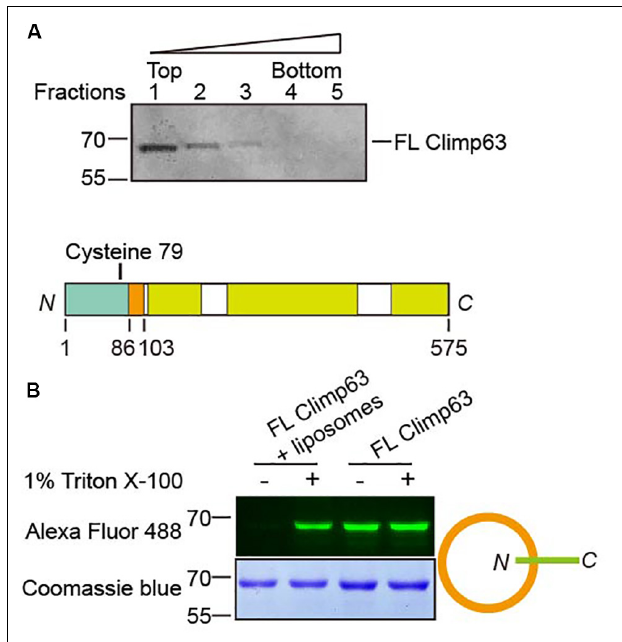
FIGURE 3 | Reconstitution of Climp63. (A) FL Climp63 was reconstituted into proteoliposomes followed by flotation analysis. Fractions were analyzed by SDS-PAGE and Coomassie blue staining. (B) The top panel shows a single cysteine in M. musculus Climp63. Purified and reconstituted FL Climp63 were labeled by a 10-fold molar excess of Alexa Fluor 488 C5 maleimide dye, with or without 1% Triton X-100, overnight at 4 ◦ C. The reactions were stopped by 2 mM BME. Samples were separated by SDA-PAGE and analyzed by fluorescent imaging (top) and Coomassie blue staining (bottom). The orientation of the reconstitution is indicated on the